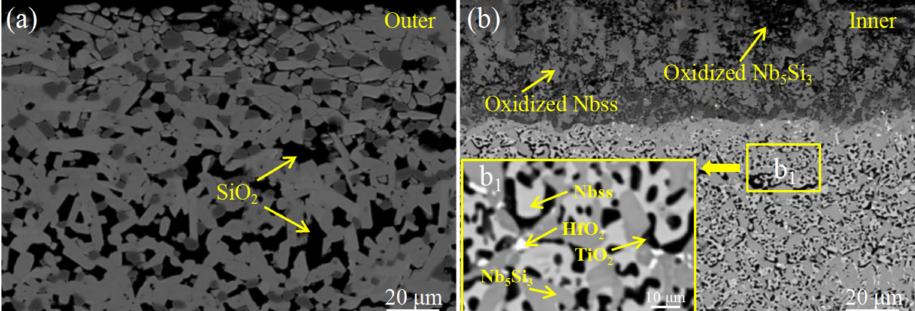
Figure 12. Cross-sectional microstructure of Nb-15Si-24Ti-4Cr-2Al-2HF-1V (at.%) alloy in outer layer ( a ) and inner layer ( b ) after oxidation, and the enlarged images of the yellow rectangular zones (b 1 ). Copyright 2017 Elsevier.